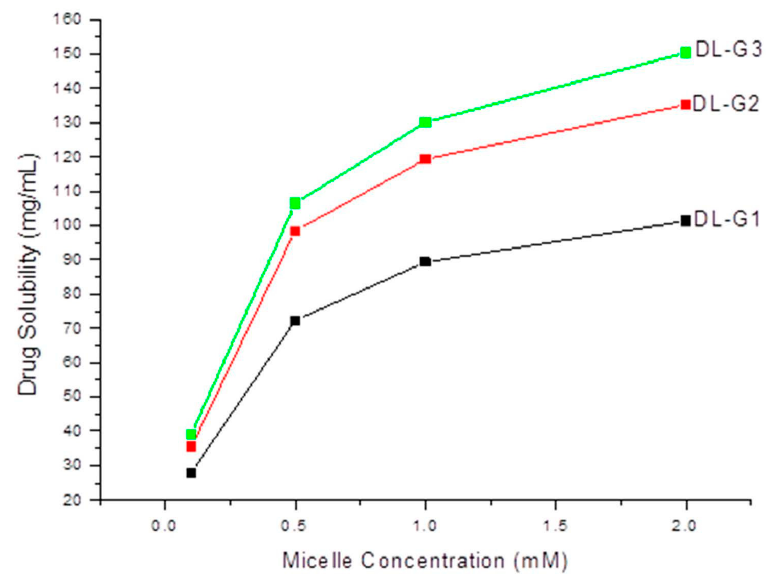
Figure 2. Solubility of 5-FU in different concentration of DL-G1, DL-G2, and DL-G3 micelles.